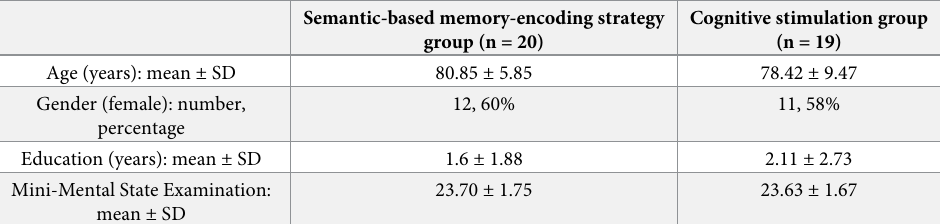
Table 1. Demographic data and mini-mental state examination scores.